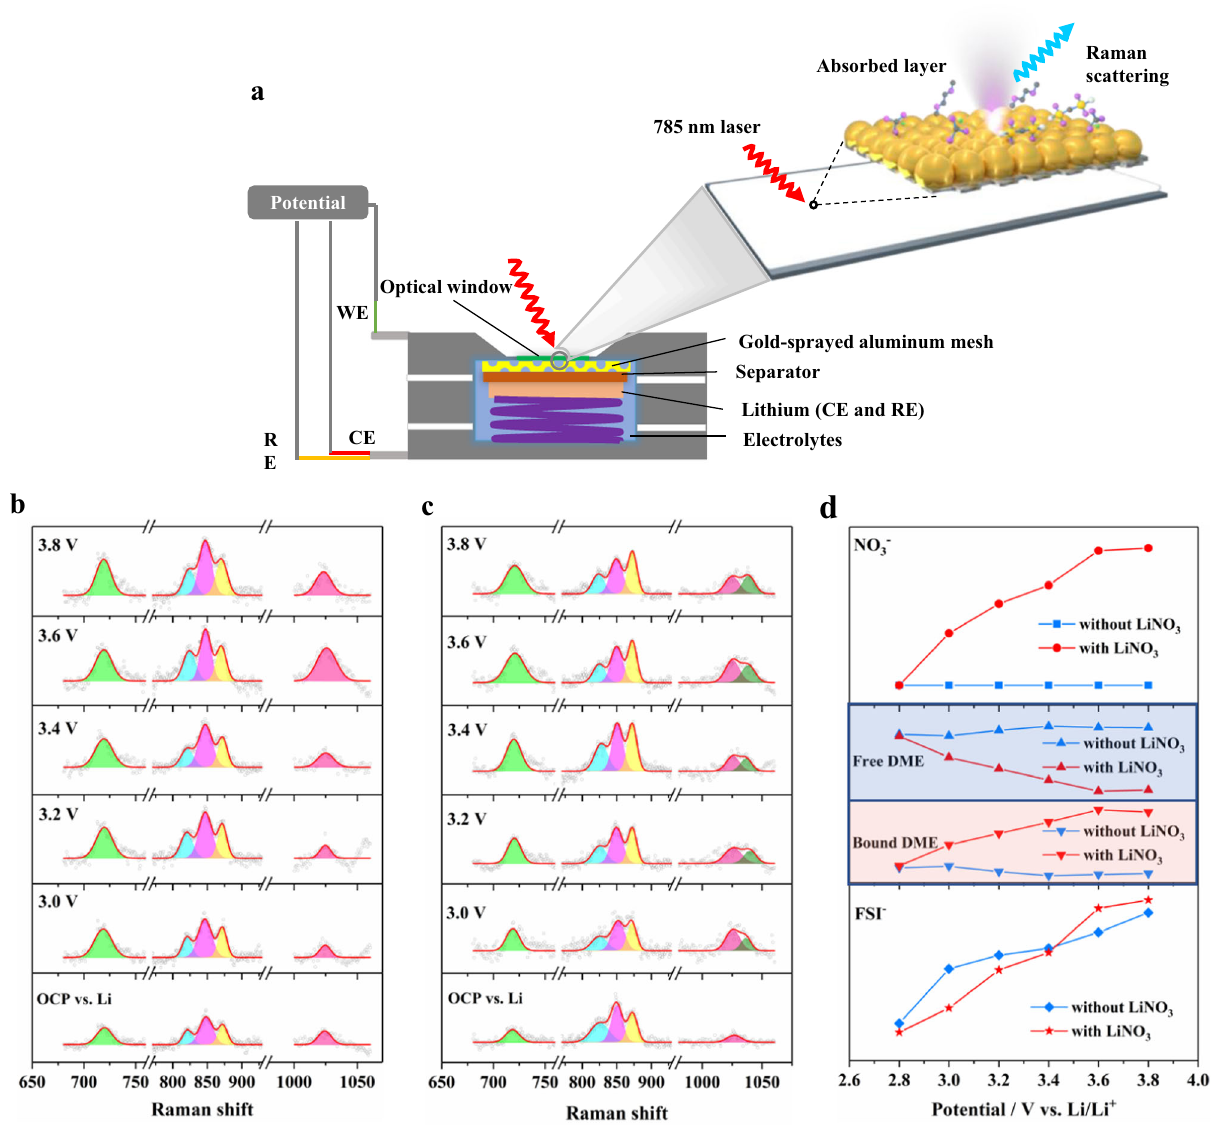
Fig. 6 In situ EC-SERS characterization of EDL structure under different voltages. a Schematic of an in situ EC-SERS cell, which was composed of a gold- sprayed aluminum mesh as a working electrode, a lithium foil as a reference electrode and counter electrode. Raman spectra of the surface layer of the working electrode under different voltages in ( b ) 1 M LiFSI/DME and ( c ) LiFSI – LiNO 3 /DME. d The variation trend of each component (NO 3 − , Free DME, Bound DME, FSI − ) in the double layer of the two electrolytes with respect to